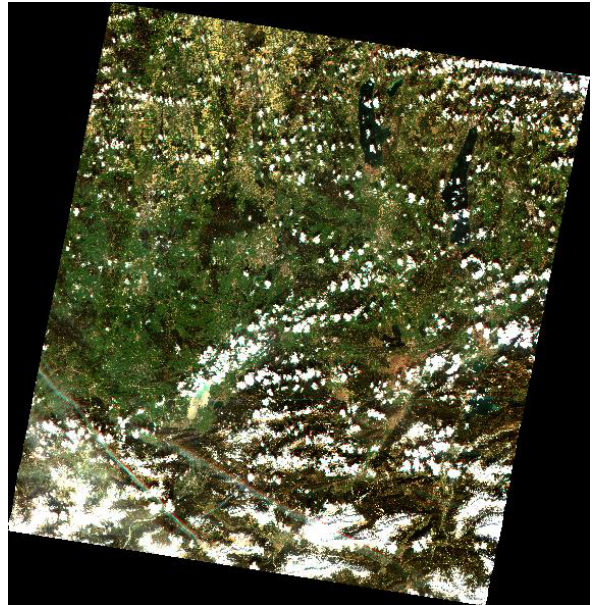
Figure 20: RapidEye Scene used for assesment, west of Munich, 100 × 100 km